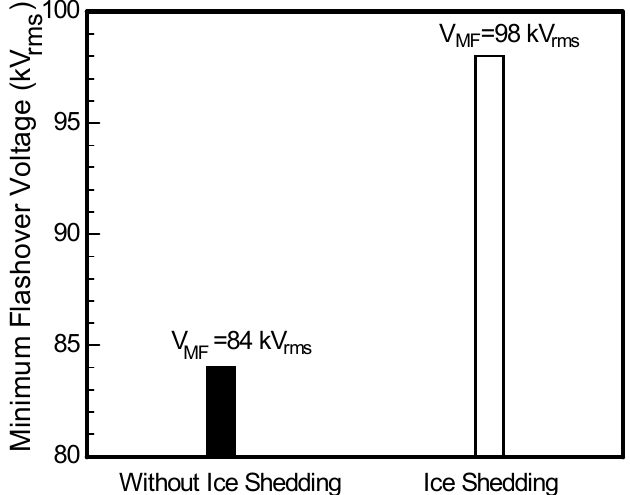
Figure 3 . Minimum flashover voltage (VMF) of ice-covered insulators with and without the occurrence of ice shedding